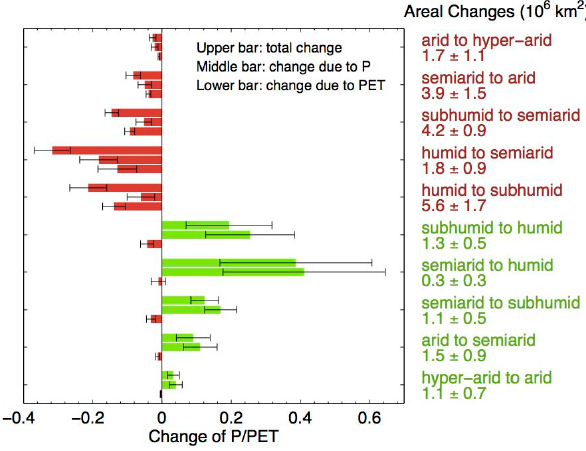
Fig. 9. Changes in P /PET (upper bar) and contributions of precip- itation (middle bar) and PET (lower bar) to P /PET changes from 1961–1990 to 2071–2100 for RCP8.5, averaged over changed areas of drylands from 27 models. Error bars give the one standard devia- tion of the 27 models. The numbers on the right show the projected area changes.